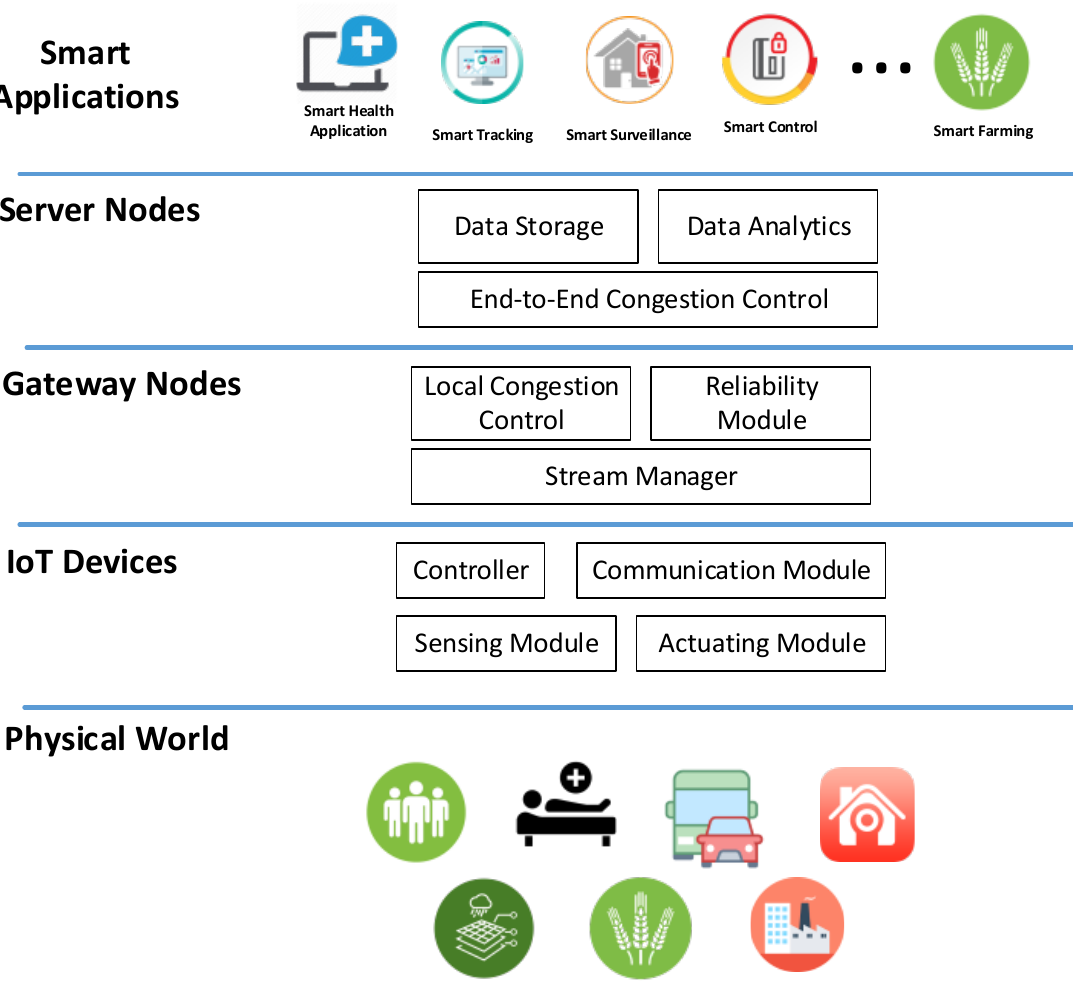
Figure 1. Layered architecture of IoT-based system with typical application scenarios for sensor